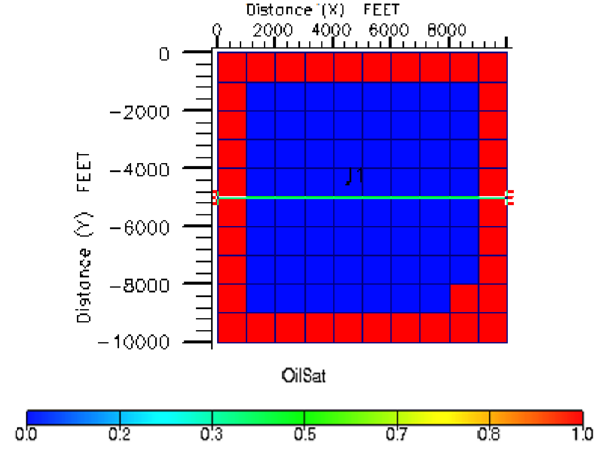
Table 2 Hypothetical reservoir data used to build the numerical